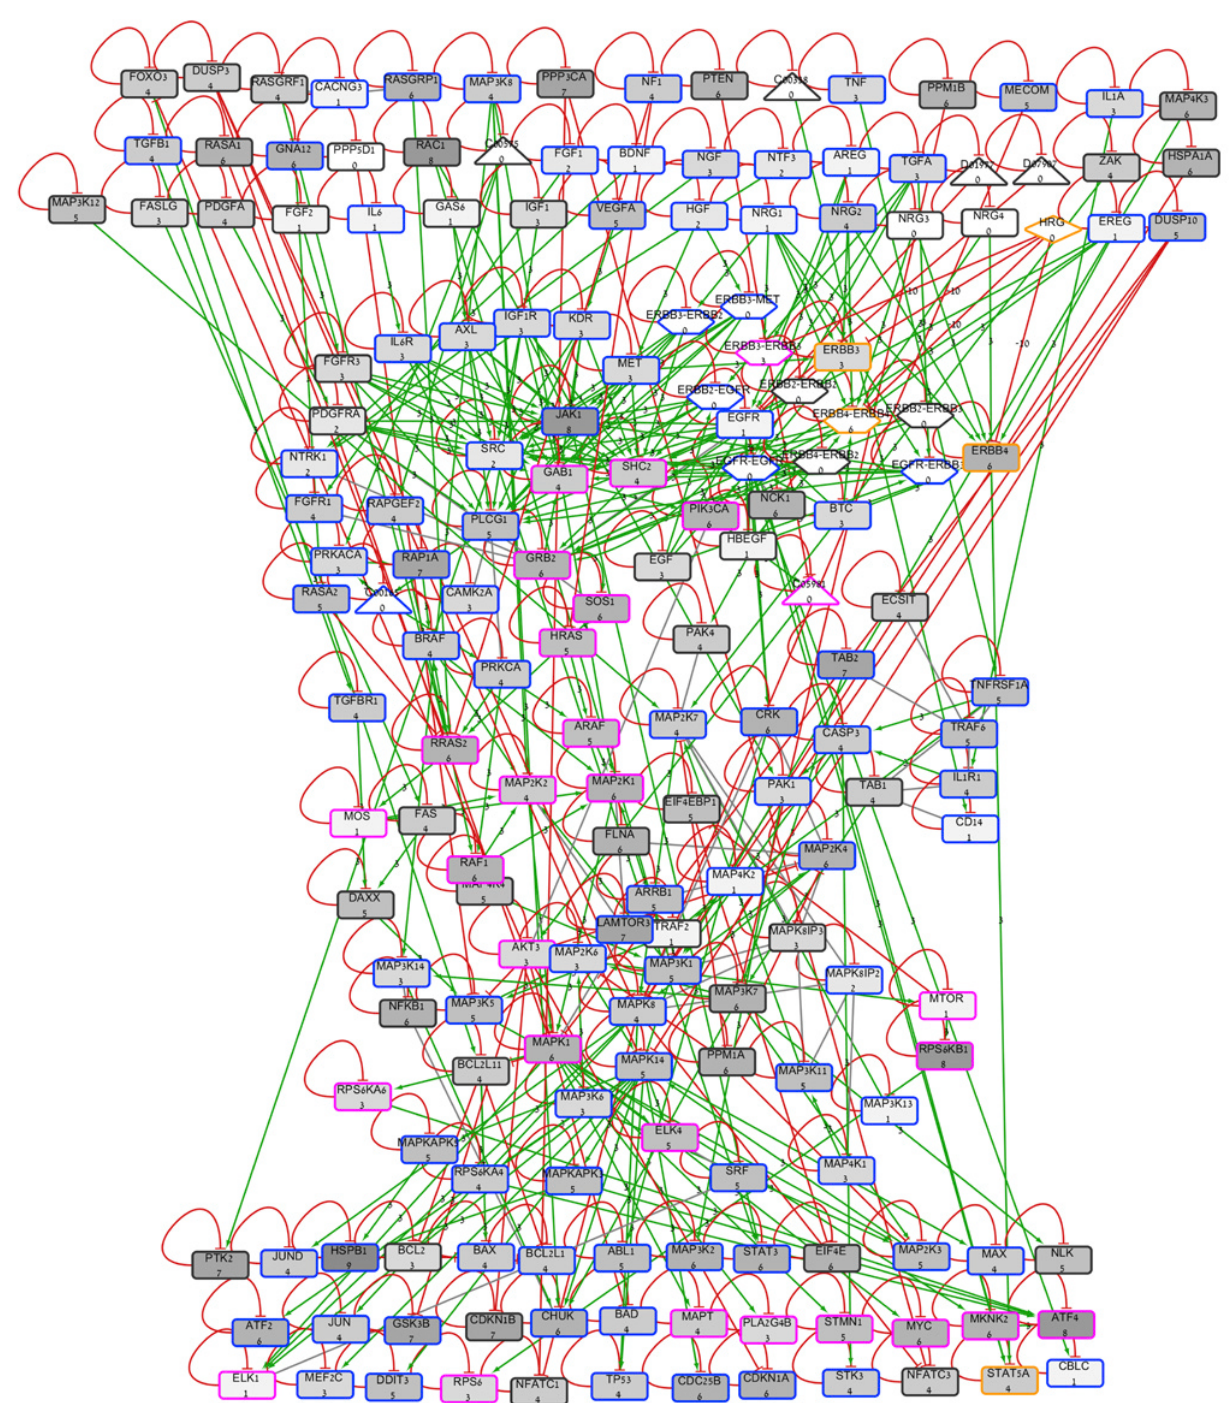
Figure 5. HRG network view. A network of 190 genes consisting of 3 KEGG pathways (described in the text), using control expression values is shown. Gene frames color code: common genes to the two analyses (pink), unique to prediction of artificial HRG treatment vs control (orange), unique to simulation resulting from HRG treatment vs control expression analysis (blue) or unchanged (black). The network shows genes with nodes fill color grayscale according to expression values and edge colors according to type of interaction (activation–green; inhibition-red). For convenience, genes or proteins are represented as rectangles, compounds as triangles and complexes (dimers) are hexagons. HRG treatment is presented as orange-framed